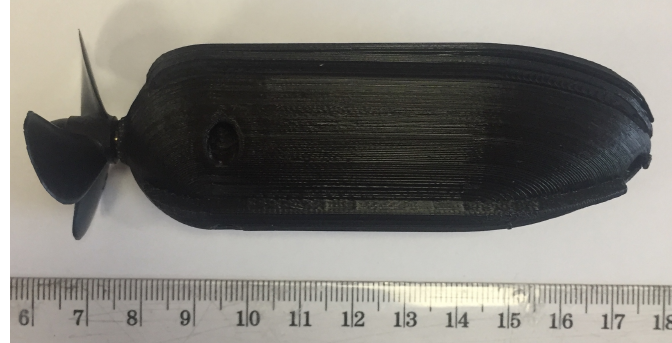
Figure 2. Custom built autonomous submersible robot.